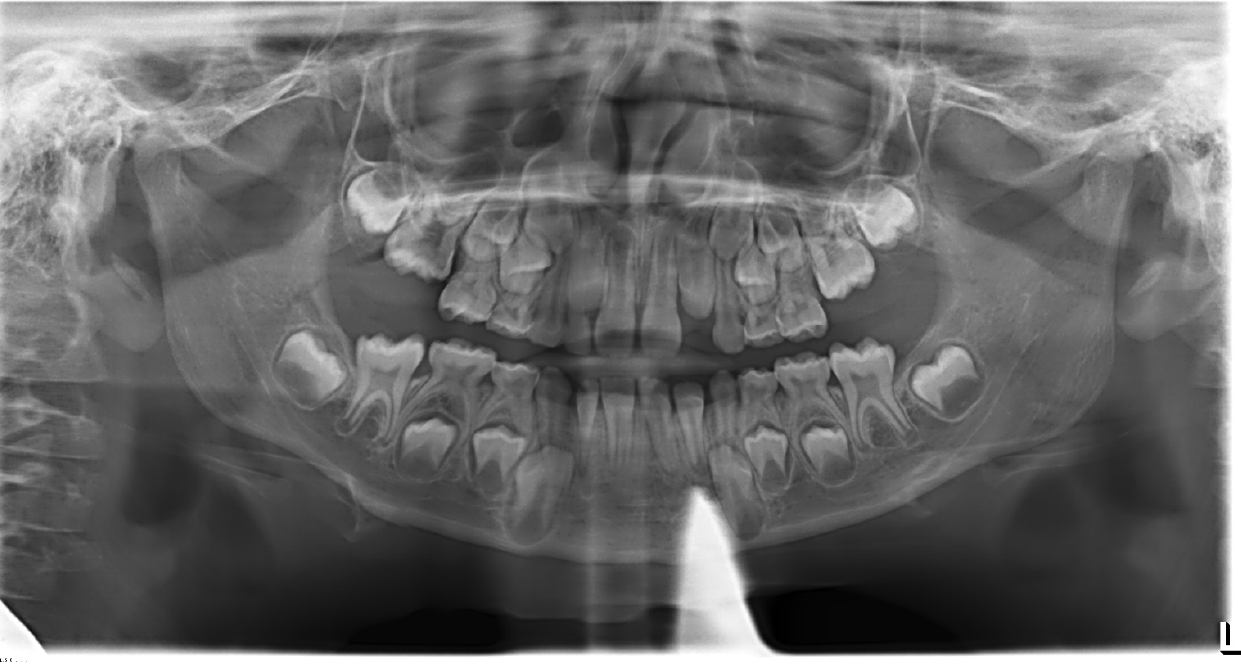
Figure 28. Radiographs of the patient at the screening. Orthopantomography X-ray after treatment (9-year-old).